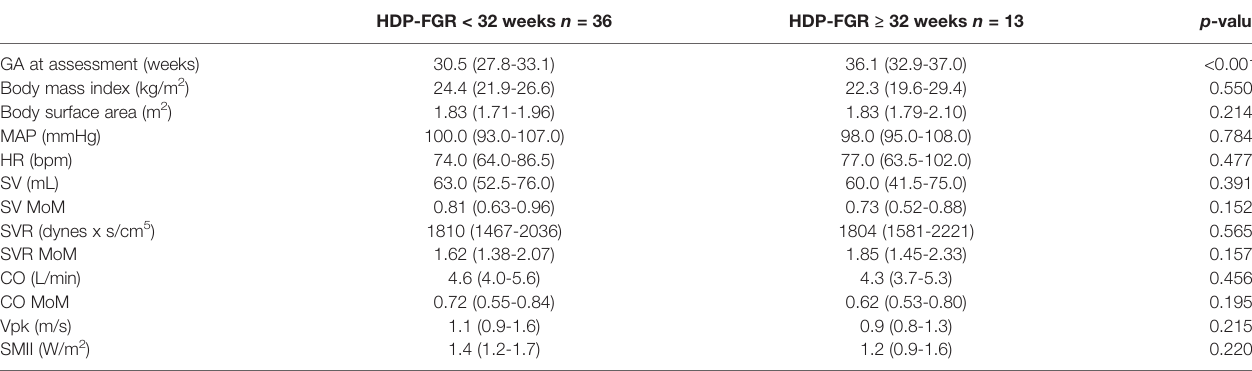
TABLE 3 | Hemodynamic assessment among pregnancies complicated by HDP-FGR. HDP-FGR < 32 weeks n = 36 HDP-FGR ≥ 32 weeks n = 13 p -value GA at assessment